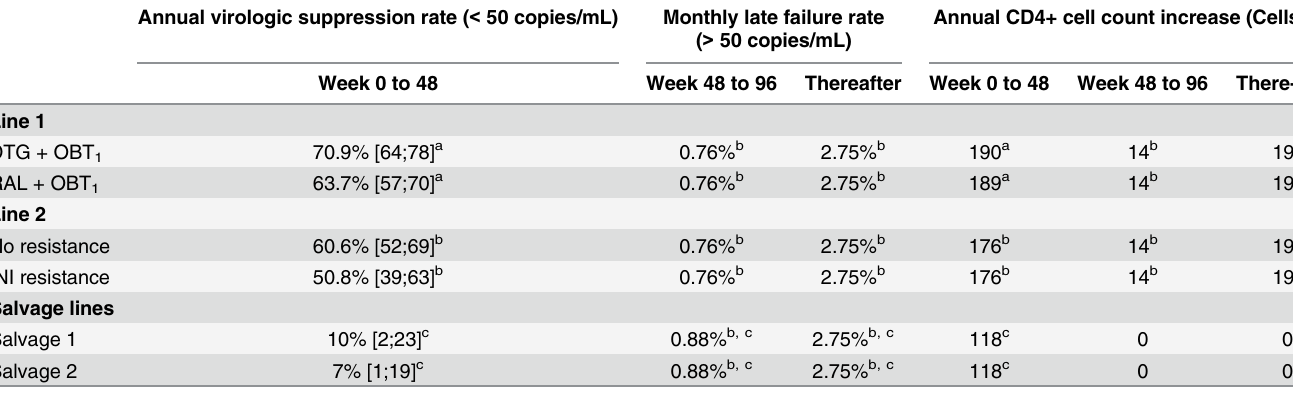
Table 2. Efficacy data, by treatment line in the